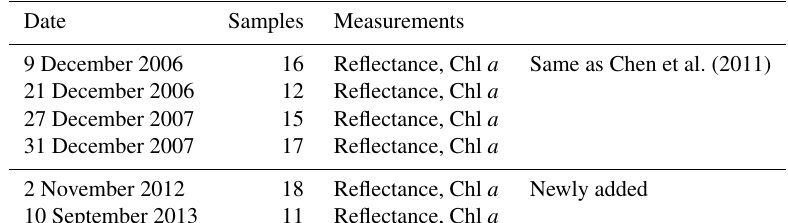
Table 1. The 89 in situ